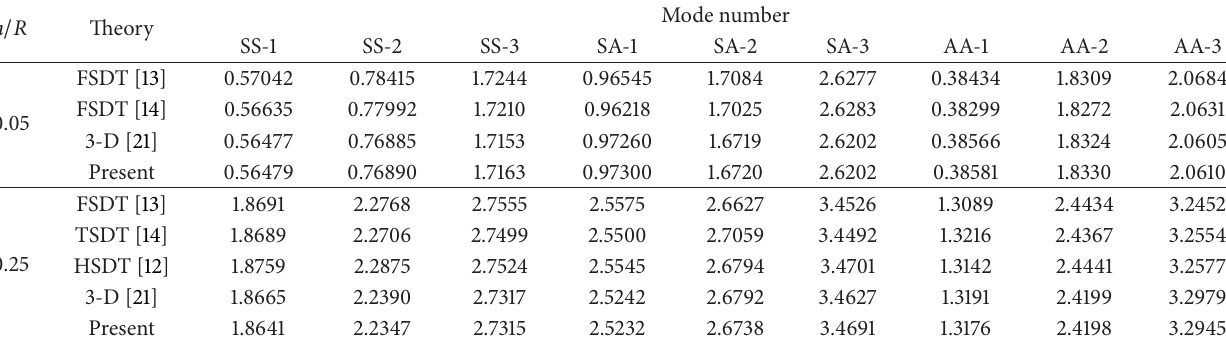
Table 11: Comparison of frequency parameters Ω = 𝜔√𝜌/𝐸 of a FFFF open isotropic spherical shell with different thickness-radius